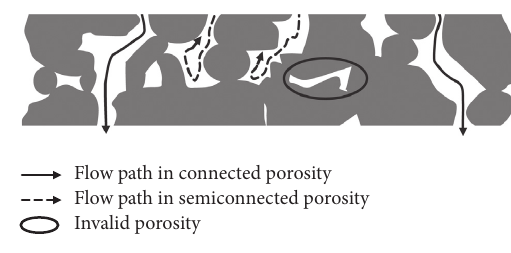
Figure 3: Porosity inside the asphalt mixture.